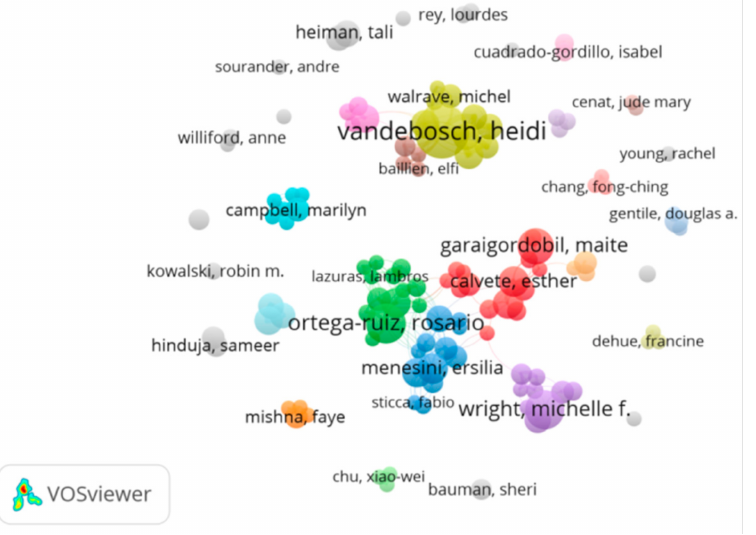
Figure 6. Authorship plot by number of